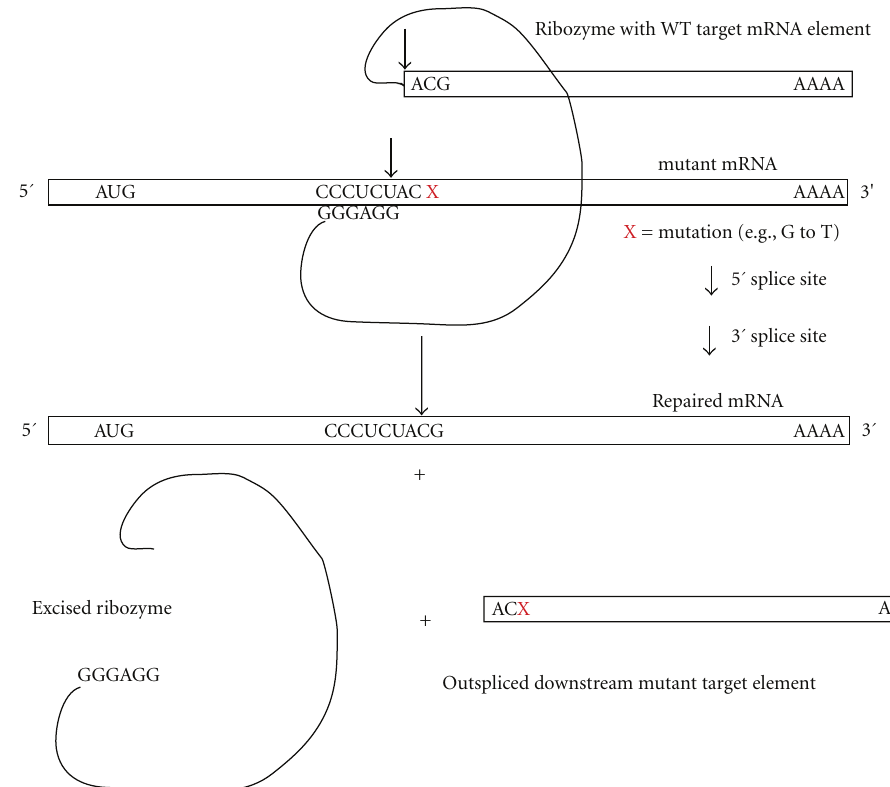
Figure 6: mRNA repair strategy for Dominant Mutations. The trans- splicing group I intron of Tetrahymena is engineered with an element that contains a WT mRNA sequence starting from just upstream of the mutation(s) in the target mRNA (labeled X). The Group I intron recognizes the region upstream of the target by way of complementary base pairing. It then cleaves the target using free guanosine as a nucleophile and then trans- splices a fresh downstream WT target mRNA element at the precise site of cleavage. All mutations in a given gene below the splice site could be treated with a single trans- splicing group I intron. One or several engineered group I introns could cover most mutations in a given human